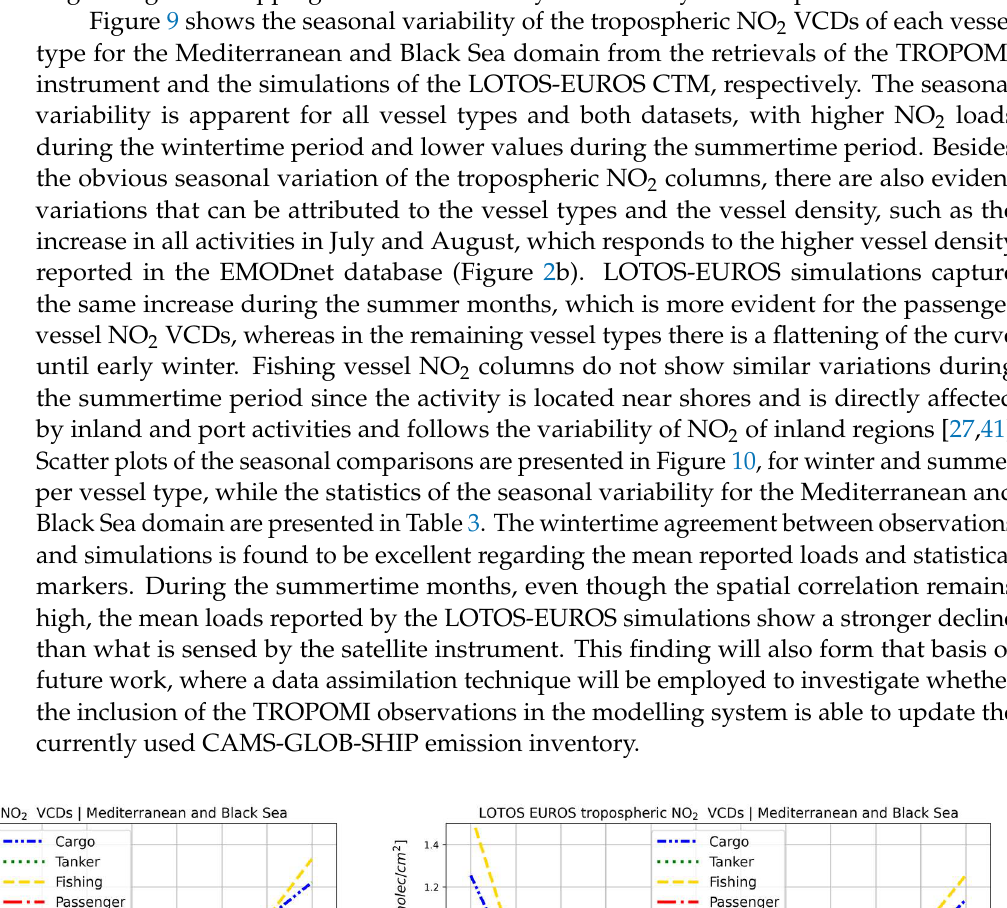
(b) Figure 10. Seasonal comparison between the tropospheric NO 2 loads reported by TROPOMI and LOTOS-EUROS over the Mediterranean and Black Sea domain per vessel type: ( a ) Winter; ( b ) Summer. Regarding the Greek domain, similar findings are reported in Figure S5, where it is shown that seasonal variation of NO 2 is more pronounced for the LOTOS-EUROS simu- lations, which is similar with the Mediterranean and Black Sea domain. The TROPOMI tropospheric NO 2 seasonal variations are also present but with more fluctuations per month. The TROPOMI columns capture an increase in August regarding the passenger vessels, possibly due to the increased tourism of this period, which is not apparent in the LOTOS-EUROS simulations. Cargo vessels seem to peak in August for the TROPOMI ob- servations, which is not evident for the model simulations. As for the entire domain stud- ied, fishing vessel NO 2 VCDs clearly depict the seasonality of NO 2 for both datasets, with highs in winter and lows in summer, proving the direct effects of inland emissions to shipping activity near shores. The fact that the scatter plots (Figure S6) do not include as many outlier points, i.e., either misidentified pixels or missing pixels for some maritime activities, is also the reason for the extremely high spatial correlations between 0.9 and